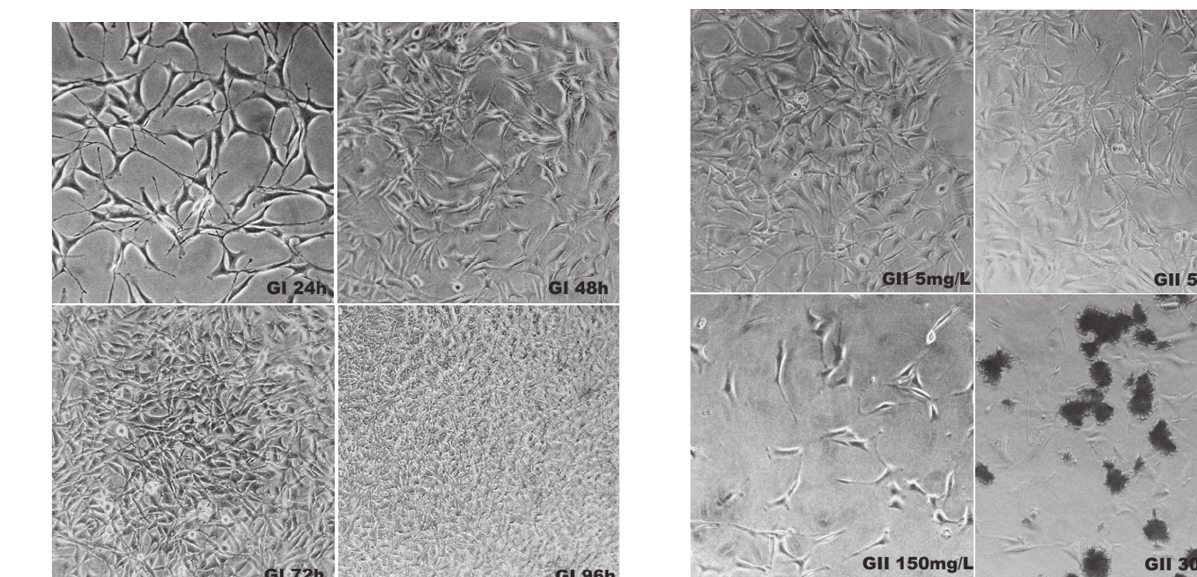
Figure 2- Photomicrographs of Group I (Control)